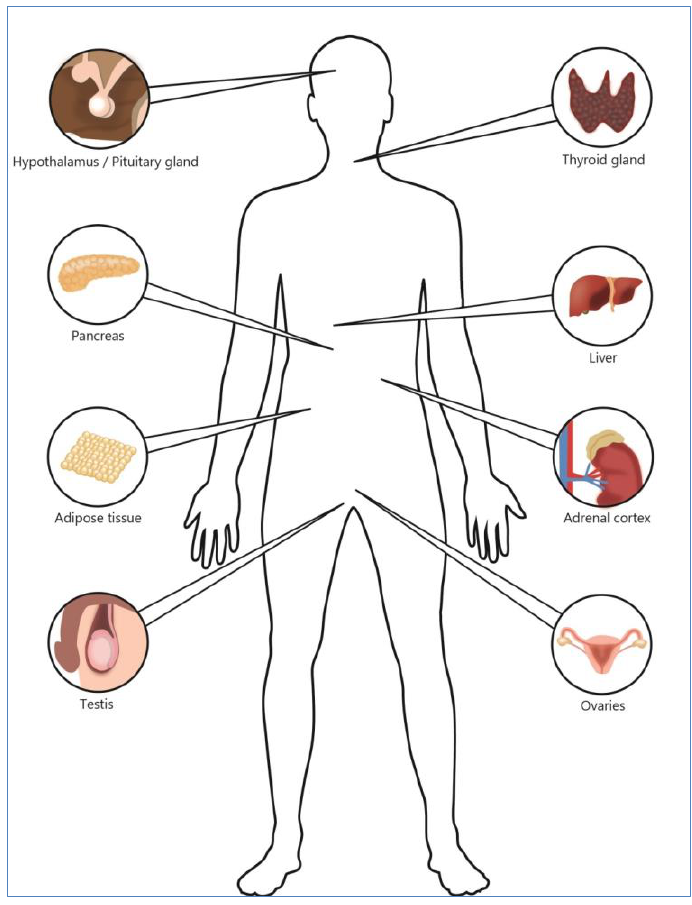
Figure 1. Endocrine organs affected by childhood AN. Due to immaturity of the child´s body and brain, endocrine disturbances may be even more devastating in childhood than in adolescence. The main endocrine changes are listed in Table 2. Table 2. Endocrine changes in childhood AN (data from References [25,26]).